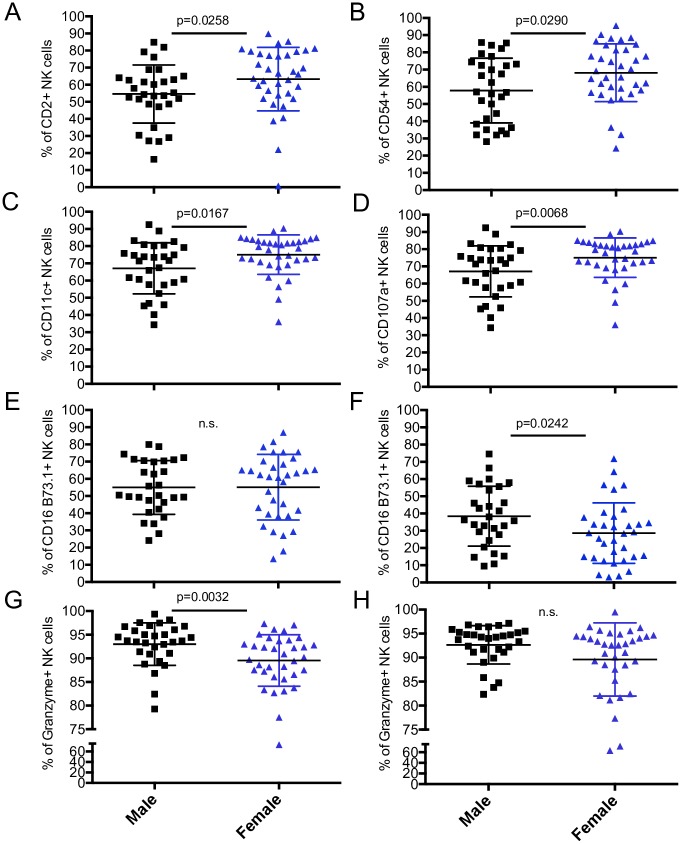
Variation in total NK cell marker expression by sex in a healthy population of adults and children.All 65 donors were pooled and divided by sex. Percentage of NK cells with positive expression of CD2, CD54 and CD11c (A-C) and CD107a after stimulation (D). CD16 (B73.1 clone) and granzyme B incubated in absence of stimulation (E, G) or stimulated with PMA/ionomycin (F, H). All markers except granzyme were detected by surface staining. Each data point represents a donor; male (n = 30), female (n = 35). All data shown is mean ± S.D. compared by Mann-Whitney test.